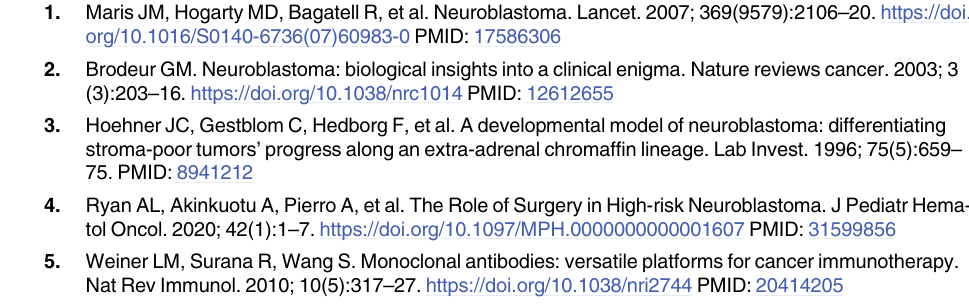
antibody was used as correction. The KD values were obtained by fitting the data to a 1:1 bind- ing model. S2 Fig. The specificity binding analysis of GRP-R mAbs. GRP-R mAbs cross binding test using ELISA coated with four different GRP-R extracellular domains E1, E2, E3, and E4. GRP-R mAb-1, mAb-17, and mAb-21 have no cross binding with GRP-R extracellular domain E2, E3, and E4. S3 Fig. Immune checkpoint PD-L1 and PD-L2 expression in neuroblastoma BE(2)-C cells. The mRNA level of PD-L1 and PD-L2 was measured by qRT-PCR and normalized to GAPDH in BE(2)-C cells treated with IFN γ at 10 ng/ml for 24 hours. S4 Fig. Immune checkpoint PD-L2 expression in neuroblastoma cells. The mRNA level of PD-L2 was measured by qRT-PCR and normalized to GAPDH in five human neuroblastoma cell lines. All cells were treated with IFN γ at 0, 1, or 10 ng/ml for 24 hours. (TIF) S1 Raw